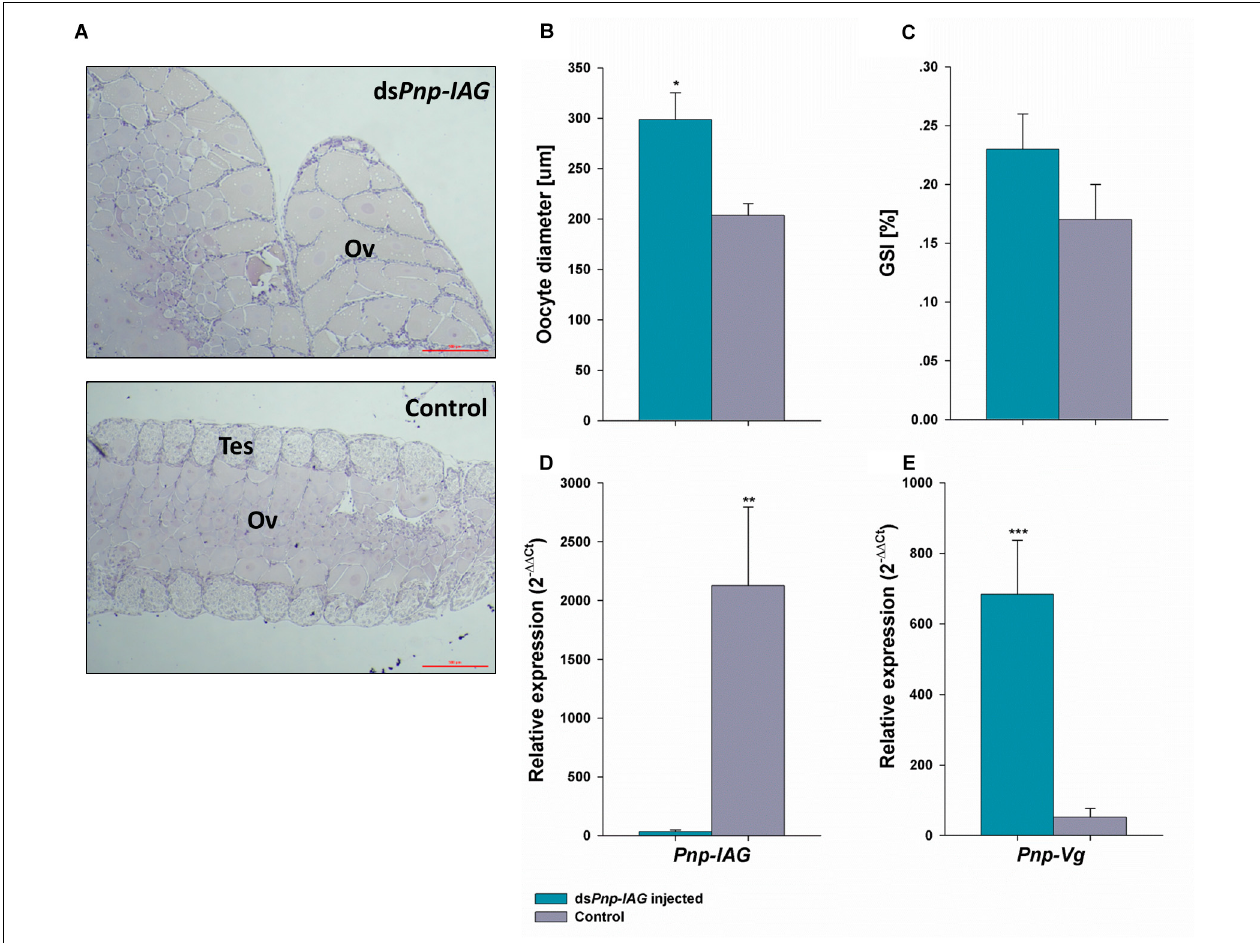
FIGURE 4 | Long term Pnp-IAG loss of function through RNAi in terms of Pnp-IAG and Pnp-Vg transcript levels and gonad anatomy. P. platyceros males were injected with ds Pnp-IAG (blue) or with crustacean saline (control; gray). (A) Representative gonad photos of ds Pnp-IAG injected (top) and control (bottom) animals. Ovarian (Ov) and testicular (Tes) tissues are indicated. Bar scales (= 5 µ m) are consistent in both photos. (B) Oocyte diameter and (C) Gonadosomatic index ( n treatment = 11, n control = 8). (D) Pnp-IAG relative expression levels ( n treatment = 9, n control = 5). (E) Pnp-Vg relative expression levels ( n treatment = 9, n control = 8). Error bars represent standard error of the means. P -values are denoted: * P < 0.01, ** P < 0.001, *** P <